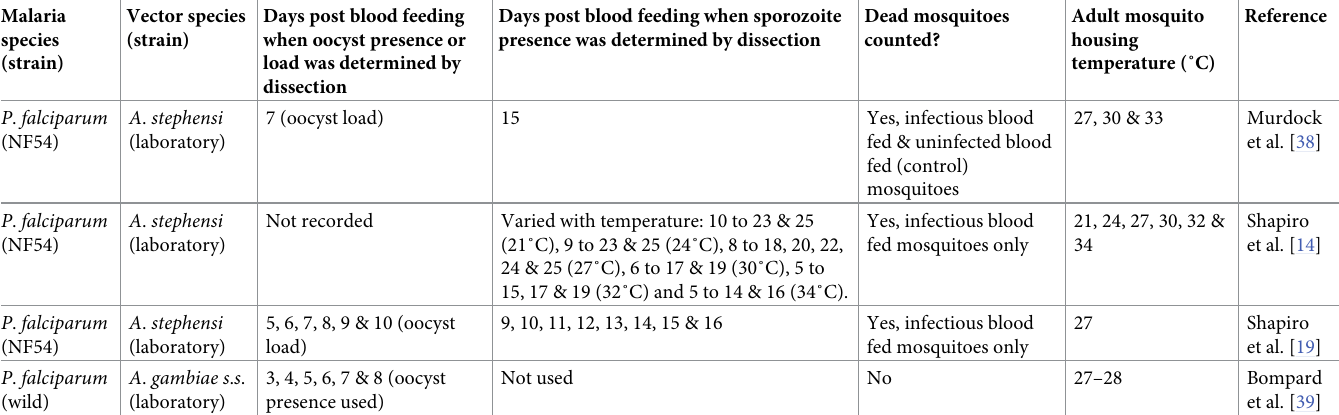
Table 1. Summary of different studies, parasite-vector combinations and experimental proceedures used to parameterise the